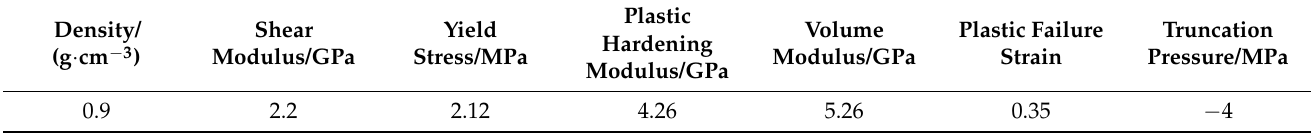
Table 1. Mechanical property parameters of ice materials.